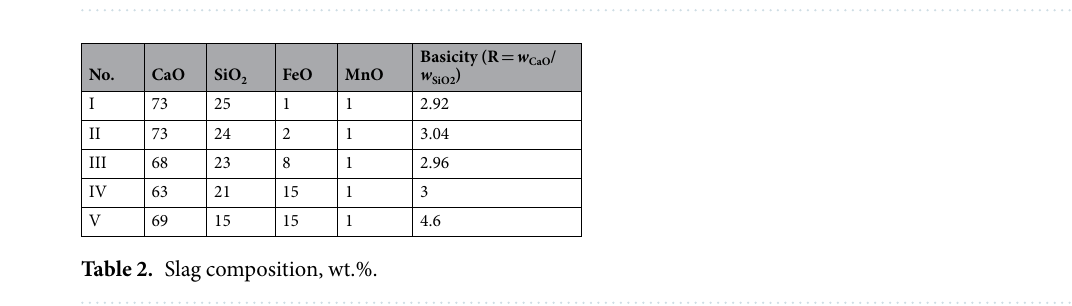
Table 1. Ultra-low carbon steel composition at the end of RH refining, wt.%.